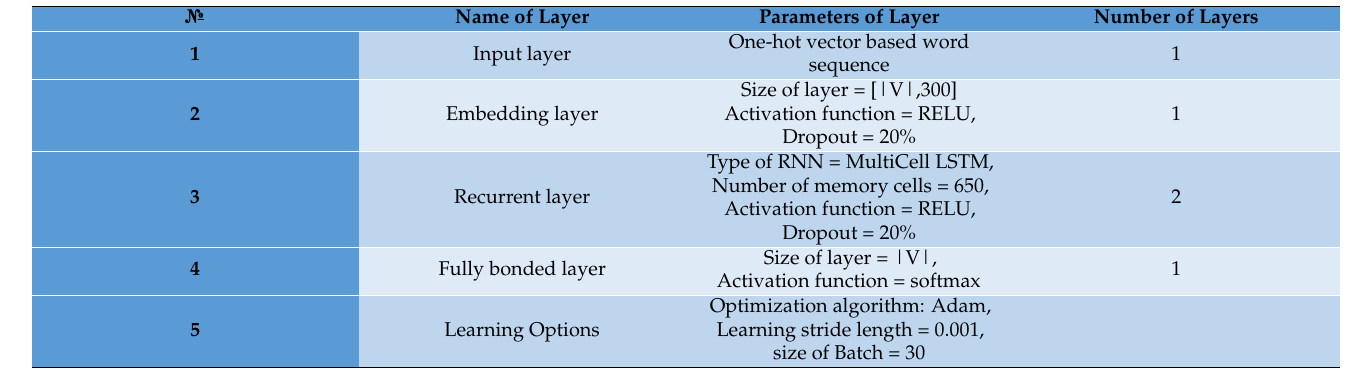
Table 1. Network parameters.